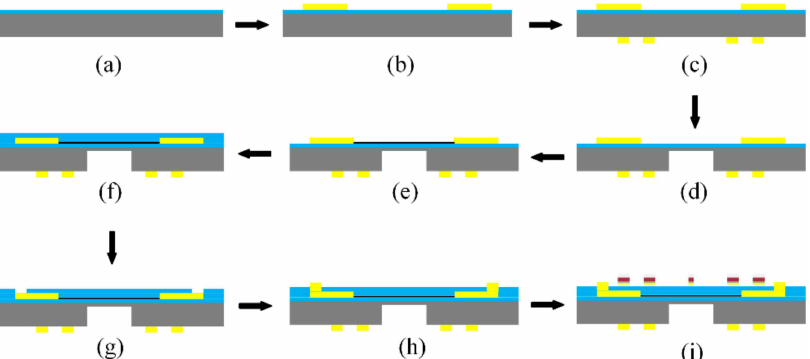
Figure 4. Schematic of the process for fabrication of the core chip. ( a ) Depositing the front SiN x . ( b ) Sputtering the bottom electrodes. ( c ) Sputtering the back sealing rings. ( d ) Etching the back pressure cavity. ( e ) Transferring and patterning the graphene. ( f ) Depositing the insulation layer. ( g ) Etching the insulation layer on electrode. ( h ) Sputtering the top electrodes. ( i ) Evaporating the front bump and sealing